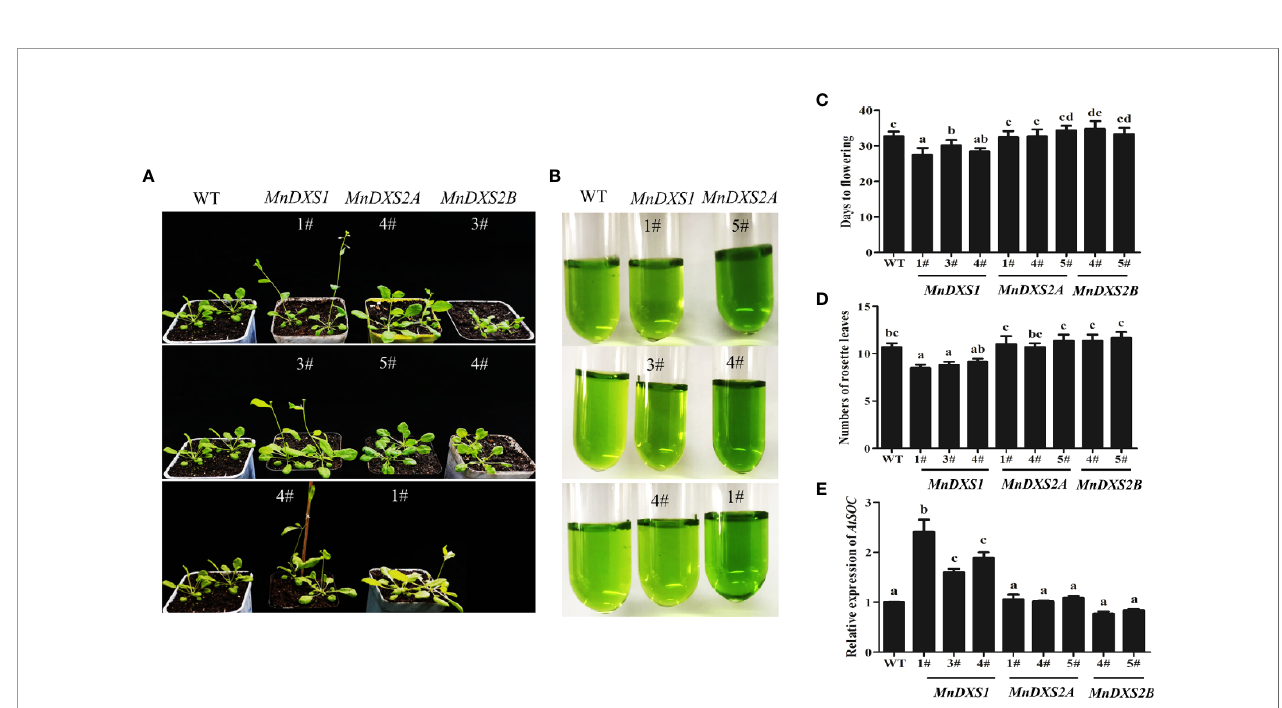
FIGURE 5 | Days to fl owering, the number of rosette leaves, and the pigment content for the WT and transgenic A. thaliana plants. (A) Phenotypes of 30-d-old wild- type and MnDXS1 -, MnDXS2A -, and MnDXS2B -overexpressing transgenic A. thaliana plants. (B) The pigment extracted solution of WT and transgenic A. thaliana plants. (C, D) Days to fl owering, the number of rosette leaves for the WT and transgenic A. thaliana plants. (E) qRT-PCR analyses of relative AtSOC1 expression levels in WT and transgenic A. thaliana plants based on a qRT-PCR assay, with Actin2 used as the internal control. Data are presented as the mean ± standard error of the mean of three replicates. Different letters above bars represent signi fi cant differences (p < 0.05) as determined with the one-way Duncan ’ s